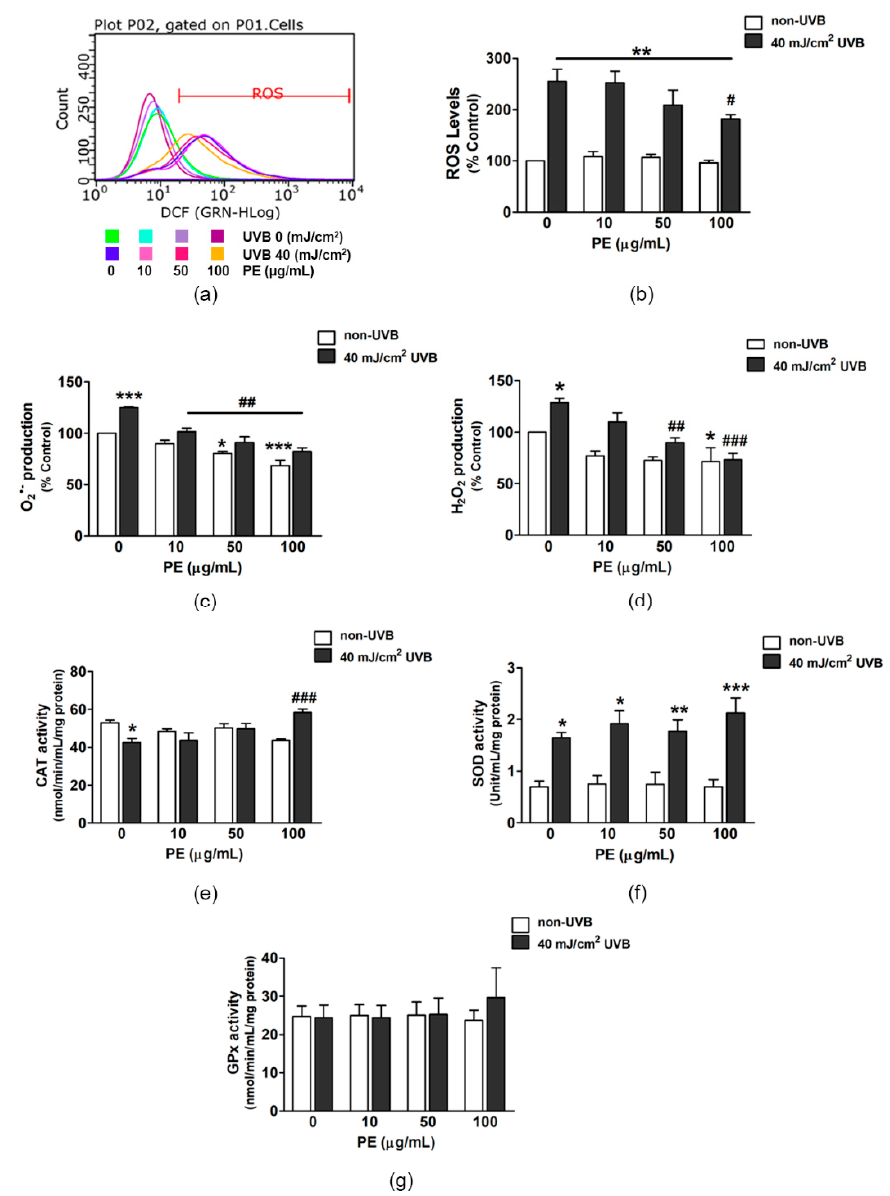
Figure 2. The effect of PE on UVB-induced intracellular ROS production and enzymatic antioxidant activity in HaCaT cells. ( a ) A fluorescent intensity diagram of DCFH-DA signals as detected by flow cytometry. ( b ) The calculated relative intracellular ROS levels in each sample group compared with those in the non-UVB group. ( c ) The intracellular superoxide (O 2 •− ) production in HaCaT cells after PE preincubation and UVB exposure. ( d ) The intracellular H 2 O 2 production in HaCaT cells following the PE incubation and UVB irradiation. ( e ) CAT activity; ( f ) SOD activity; ( g ) GPx activity. The data are shown as the mean ± SEM. *, p < 0.05; **, p < 0.01; and ***, p < 0.001, when compared to the non-UVB group; # , p < 0.05; ## , p < 0.01; and ### , p < 0.001, when compared to the UVB-exposed group.